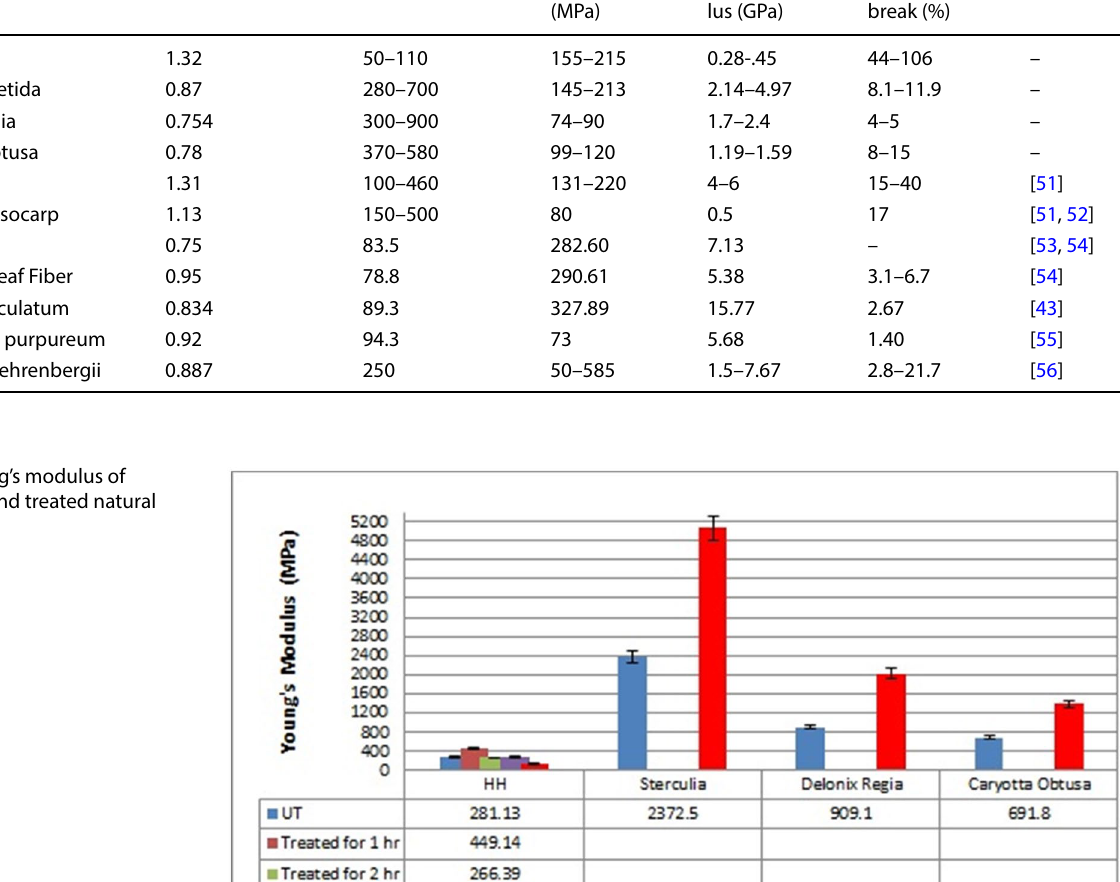
Table 9 Comparison of properties of present work natural fibers with other natural fibers Fibers